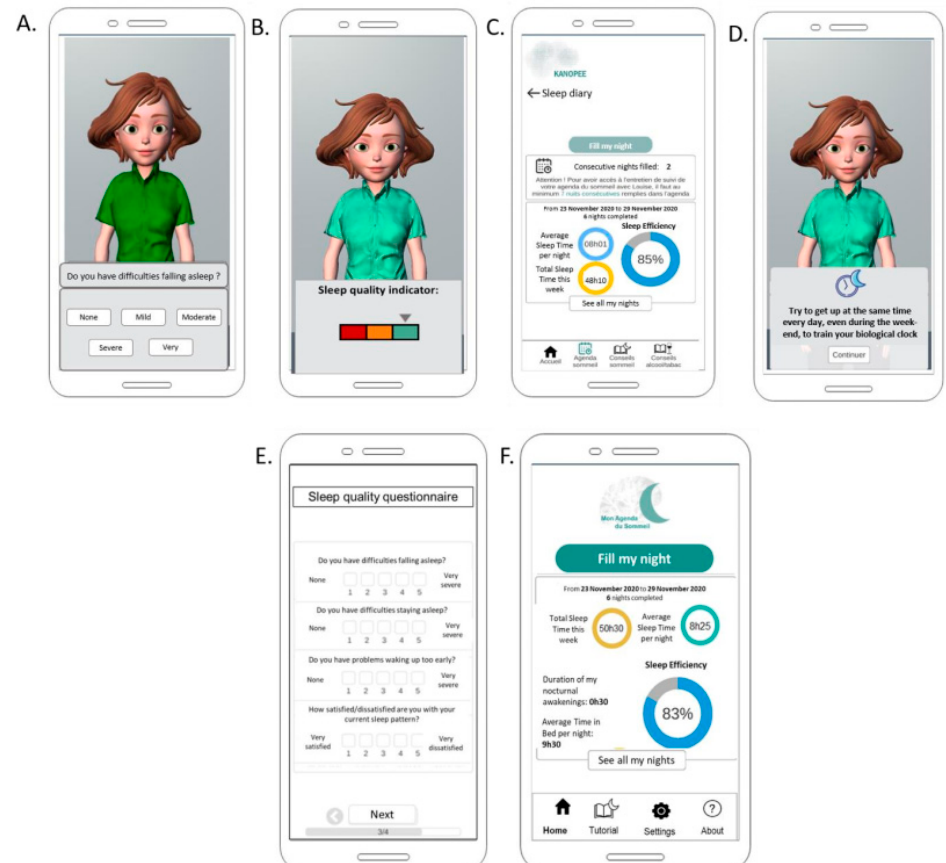
Figure 1. Examples of interfaces of KANOPEE ( A – D ) and My Sleep Diary ( E , F ) apps. ( A ) Screen- shot of Louise questioning Insomnia Severity Index. ( B ) Screenshot of visual feedback given after screening interview with Louise. ( C ) Sleep diary and visual feedback on sleep patterns in KANOPEE. ( D ) Screenshot of personalized sleep recommendation given by Louise during follow-up interview. ( E ) Insomnia Severity Index administered in My Sleep Diary. ( F ) Visual feedback on sleep patterns in My Sleep Diary.